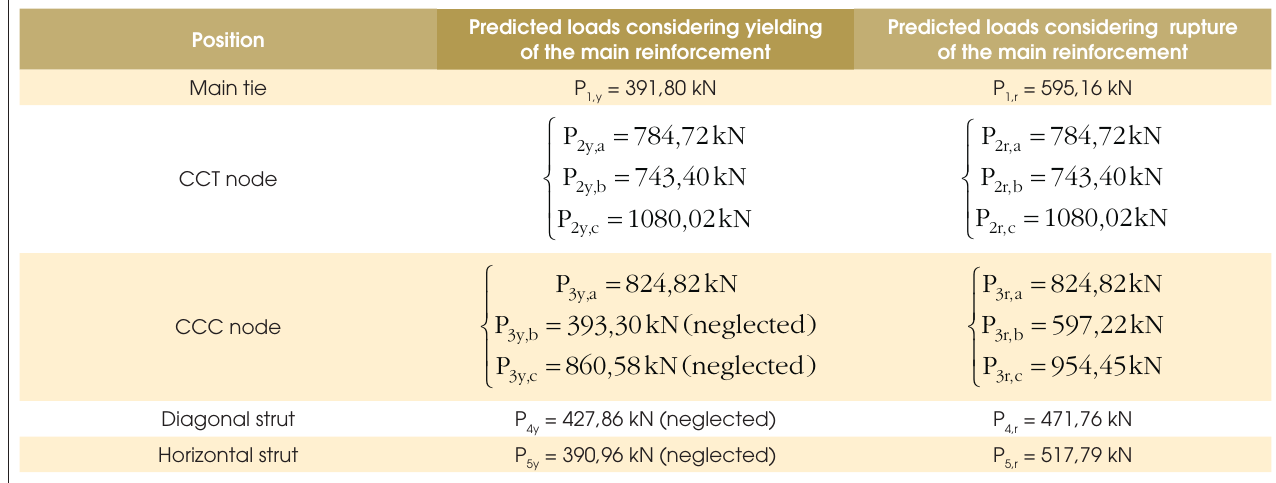
Table A.1 – Predicted loads for deep beam DB1-1.00 using the proposed strut and tie